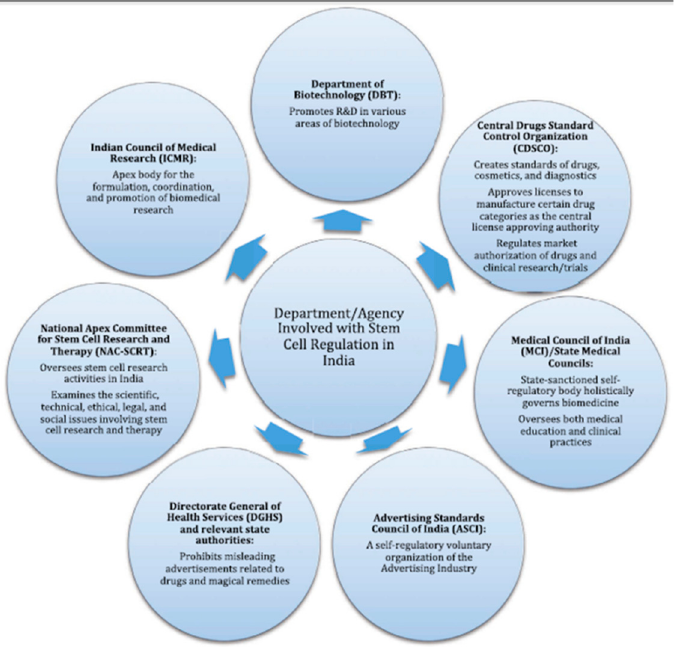
Figure 3. Process of regulatory clearance in India.